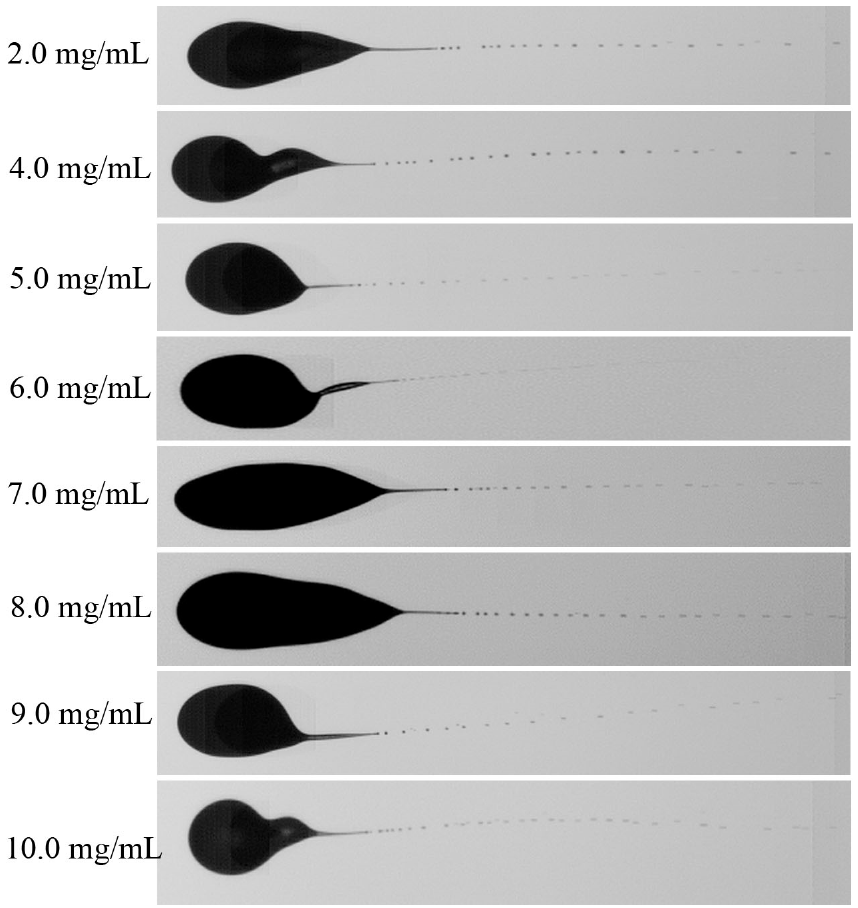
Figure 5. The secondary breakup at different Al nanoparticle concentrations.